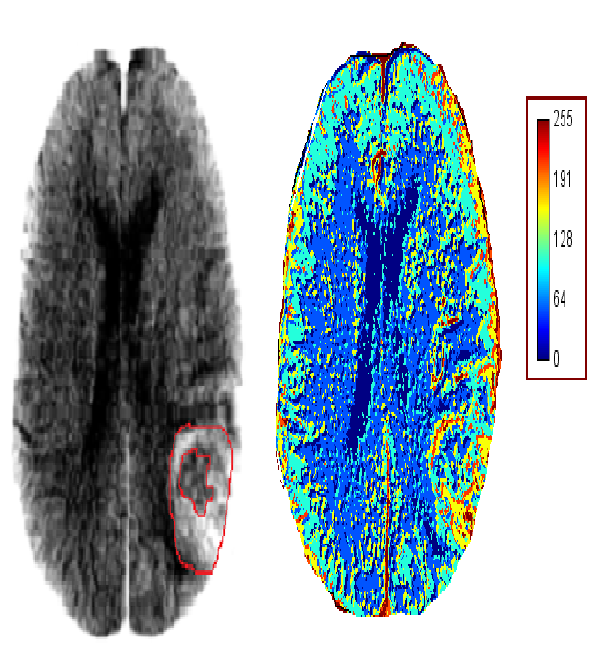
Fig.3. Compares the perfusion image HU